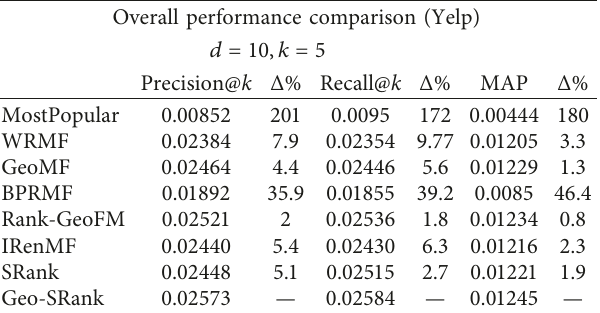
Table 3: Top- k recommendation performance on Yelp ( Δ denotes the improvement of Geo-SRank over other